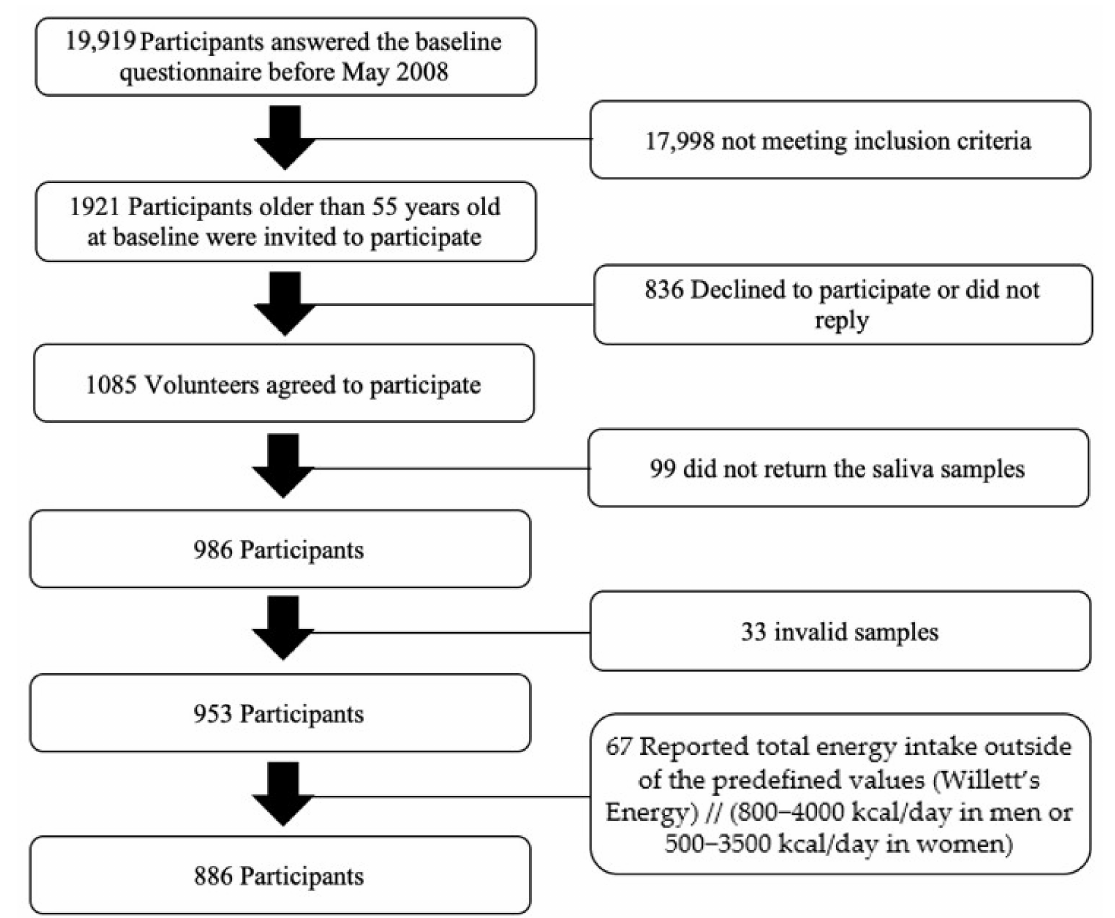
Figure 1. Flowchart of study